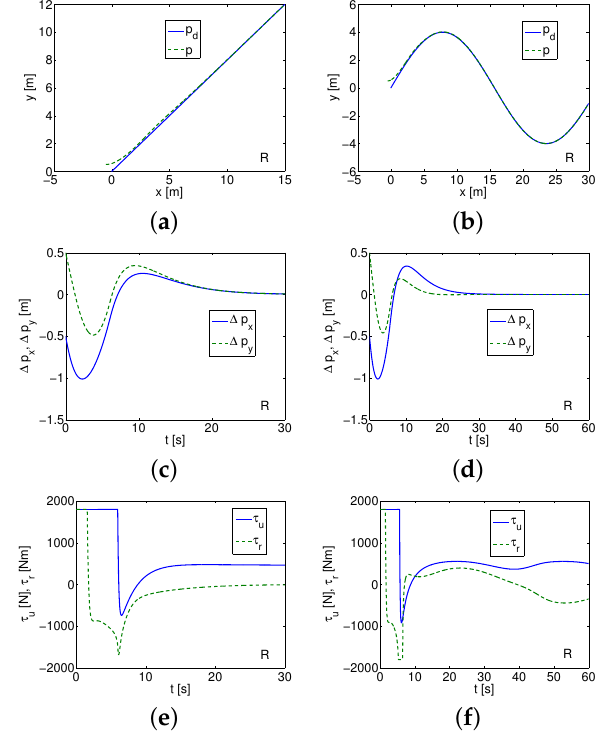
Figure 11. Simulation results for ROPOS (FTSMC)—linear and sine trajectory. ( a , b ) Desired and realized trajectory; ( c , d ) position errors; ( e , f ) applied